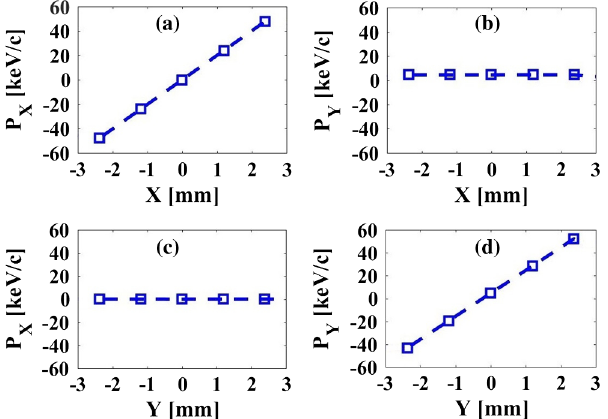
FIG. 7. Particle tracking simulation results for multipole ex- pansion based quantification of the integral kick. The MMMG phase of the gun is used. The range of the axes are set the same in all subplots for illustration.